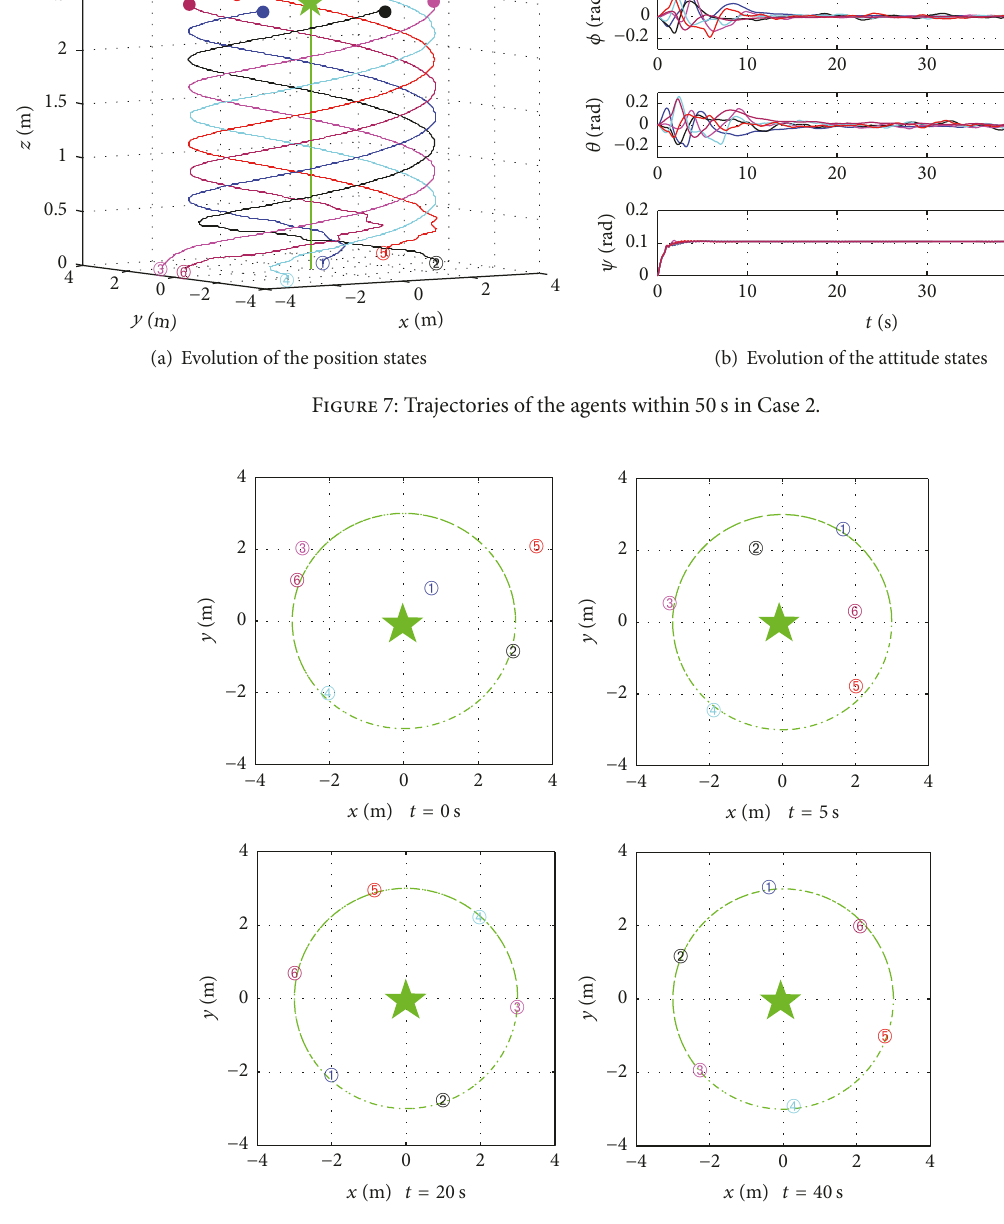
Figure 8: Position snapshots of the six agents in Case